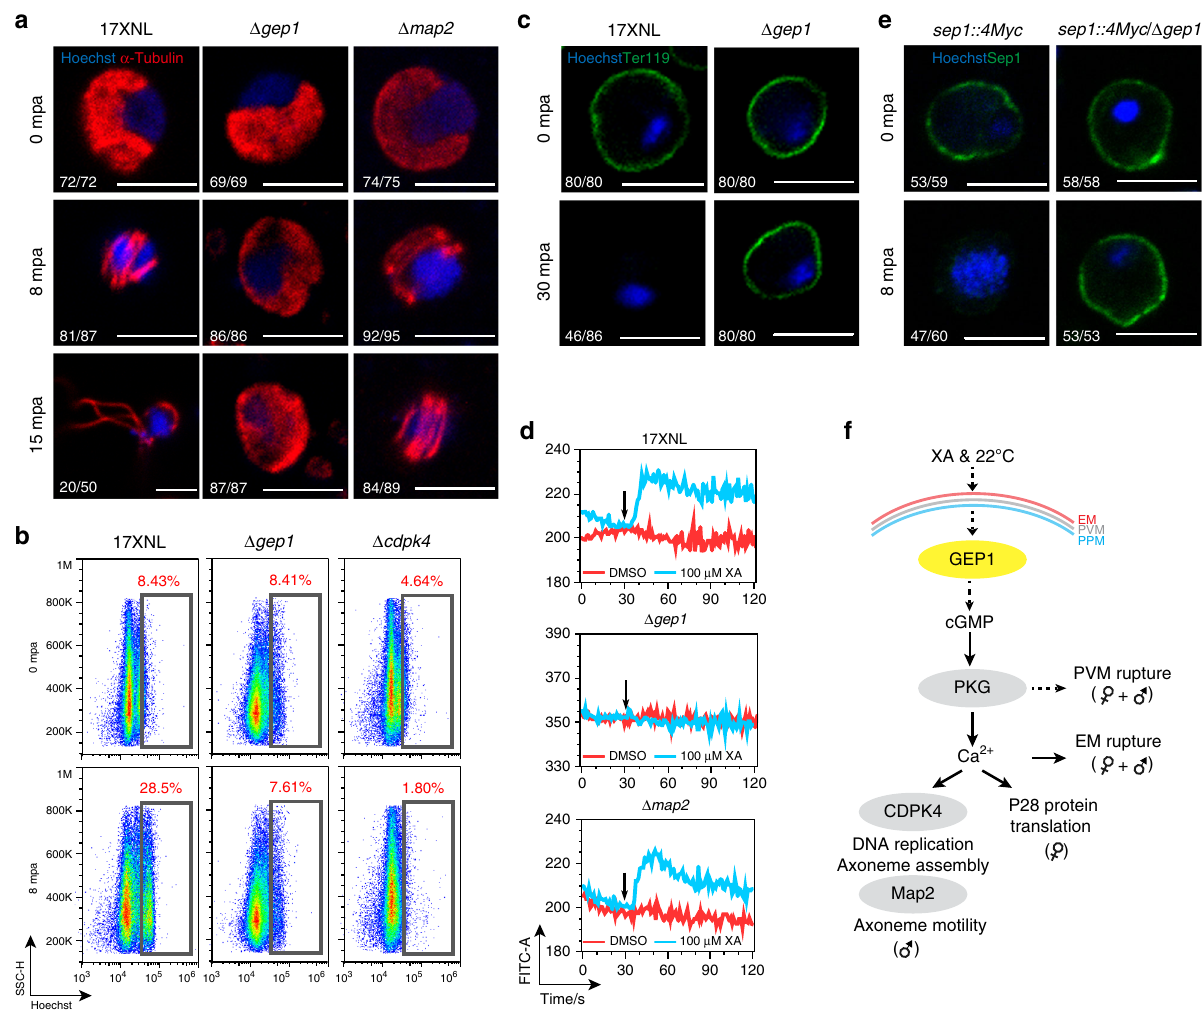
Fig. 3 GEP1 acts upstream of PKG in the cGMP-PKG-Ca 2 + signaling cascade. a α -Tubulin expression and distribution in differentiating male gametocytes from 17XNL, Δ gep1 and Δ map2 parasites after XA stimulation. mpa: minute post XA activation. b Flow cytometry analysis of genomic DNA content in XA- stimulated male gametocytes of 17XNL, Δ gep1 and Δ cdpk4 parasites. The parasites were fi xed with 4% paraformaldehyde at indicated time and stained with Hoechst. c Representative images of gametocytes stained by anti-mouse TER119 antibody 0 and 30 min post XA stimulation (mpa). d Flow cytometry detection of cytosolic Ca 2 + in gametocytes using Fluo-8 probe. Puri fi ed gametocytes were preloaded with Fluo-8, and signals were collected 30 s before addition of XA or DSMO. Black arrows indicate the time for DMSO or XA addition. e Representative IFA images of the sep1::4Myc and sep1::4Myc/ Δ gep1 gametocytes stained by anti-Myc antibody. f Proposed location of GEP1 in the XA-PKG-Ca 2 + signal cascade of gametogenesis. GEP1 depletion causes defect in both Ca 2 + -dependent and Ca 2 + -independent cellular events of gametogenesis. EM: erythrocyte membrane, PVM: parasitophorus vacuole membrane, PPM: parasite plasma membrane. x / y in a , c , and e are the number of cell displaying representative signal/the number of cell analyzed. Scale bar = 5 μ m for all images in this fi gure. All experiments in this fi gure were repeated three times independently with similar by a Plasmodium PKG protein inhibitor C2 (Fig. 4b), consistent